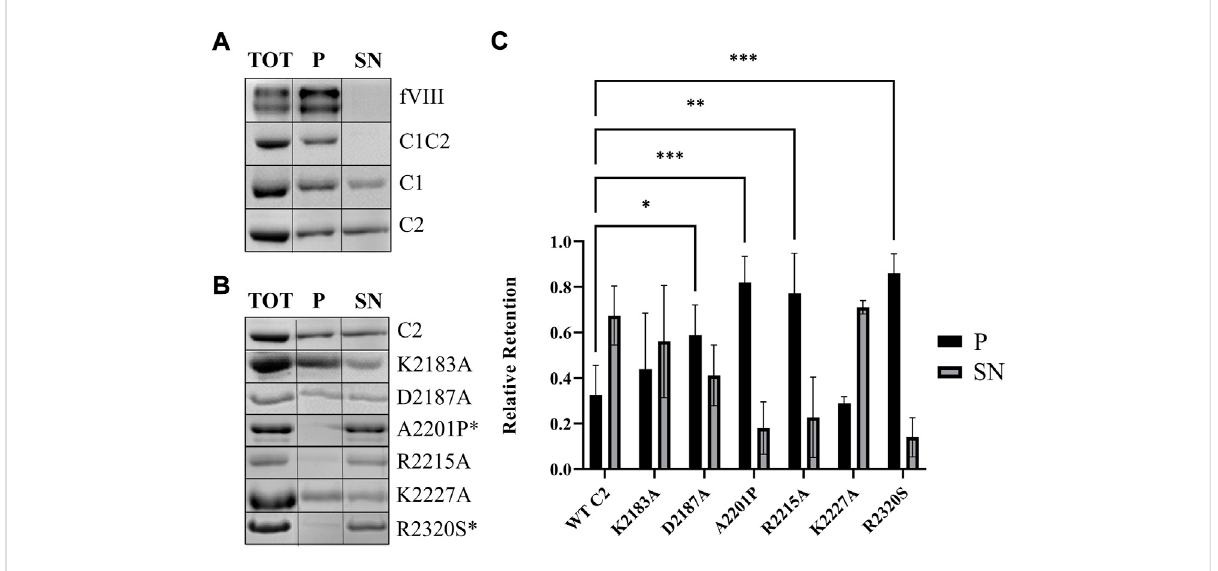
FIGURE 4 Association of fVIII C2 domains to unilamellular vesicles. (A) SDS-PAGE gel from sedimentation assay of fVIII (heavy and light chains), C1C2, C1, andC2bindingtolipidvesicles(80%PC/20%PS). (B) SDS-PAGEgelfromsedimentationassaysofwildtypeandmutantC2withlipidvesicles(80%PC/ 20% PS). Aliquots were taken from supernatant (SN) and pellet (P) to determine protein presence. Total (TOT) corresponds to the SN of 100% DOPC vesicles. *Hemophilia A-associated mutations. (C) Quantitation of liposome binding assay from Figure 3B from supernatant (black) and pellet (gray). Atwo-way ANOVA comparing eachmutanttowildtypeC2 wasperformedusingGraphPadPrism9.1.2,withthree ormoreindependenttrials, and Dunnett ’ s posttest. * p < 0.05, *** p < 0.001, **** p < 0.0001.